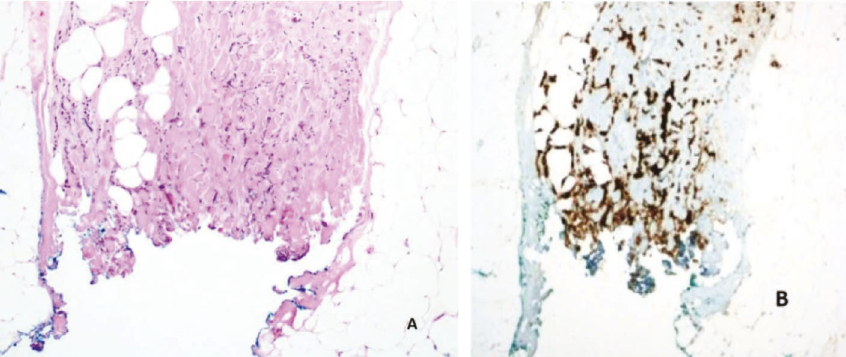
Figure 2: (a) Inability to clearly assess cellular detail at surgical margins due to electrocautery artifact (x100, HE). (b) Demonstration of tumor cells by IHC method in permanent sections (x100, IHC Cytokeratin).